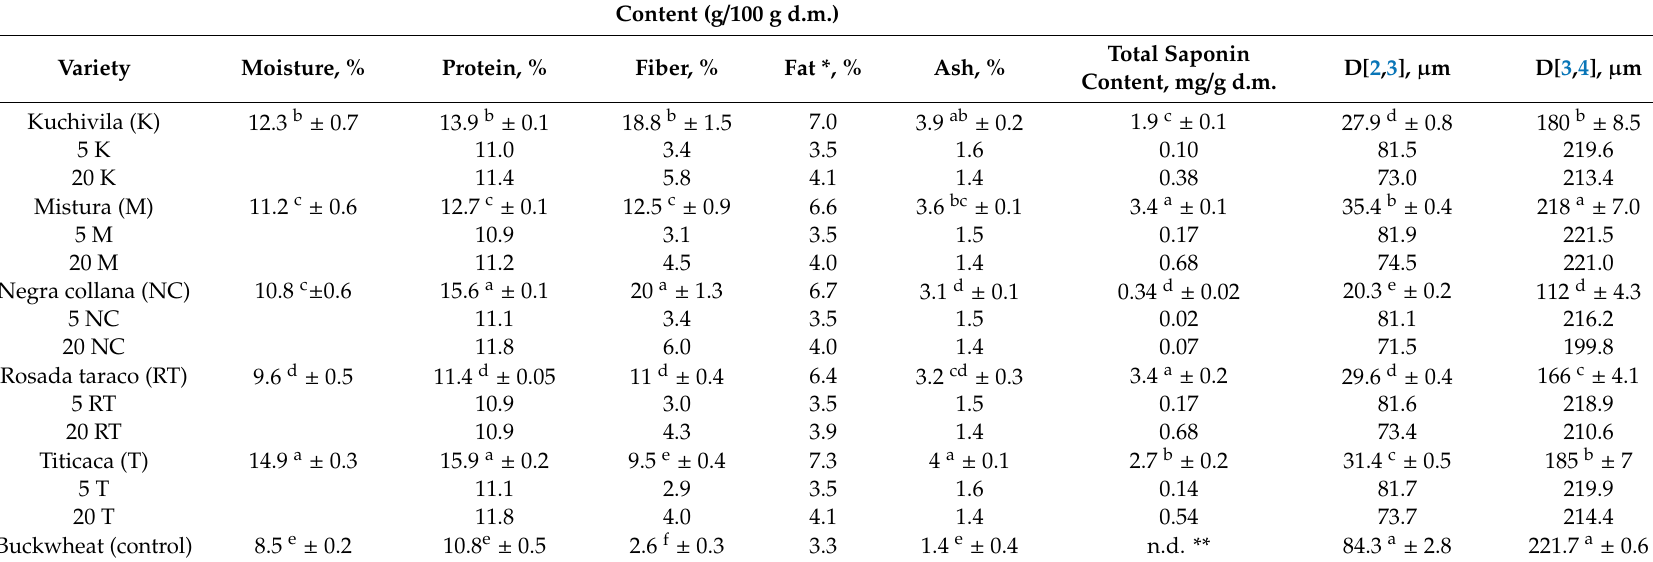
Table 1. Chemical composition and particle diameters of quinoa varieties and buckwheat flours. The calculated values of flour blends containing 5 or 20% quinoa varieties were also included. Error shows ± standard